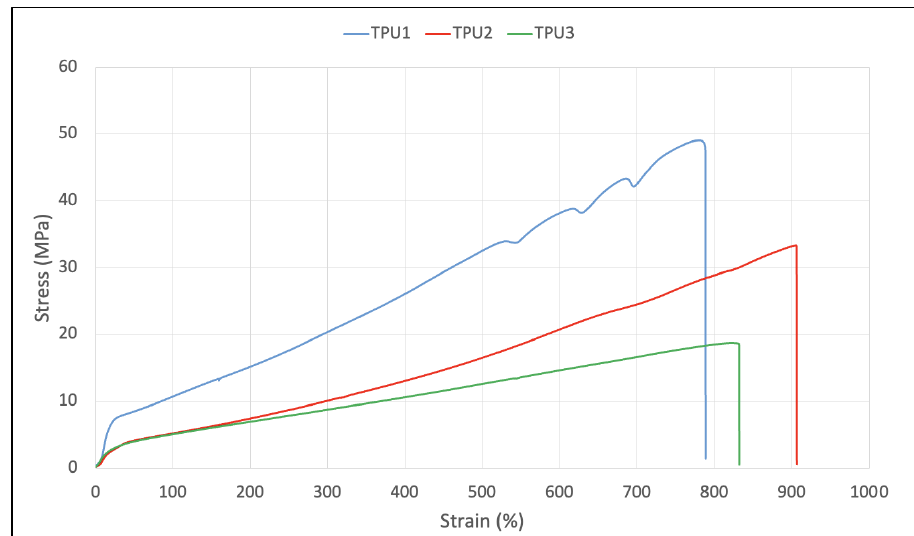
Figure 8. T he storage modulus (E’) ( A ) and tangent delta (tan  ) ( B ) as a function of temperature for TPUs determined by DMA analysis.